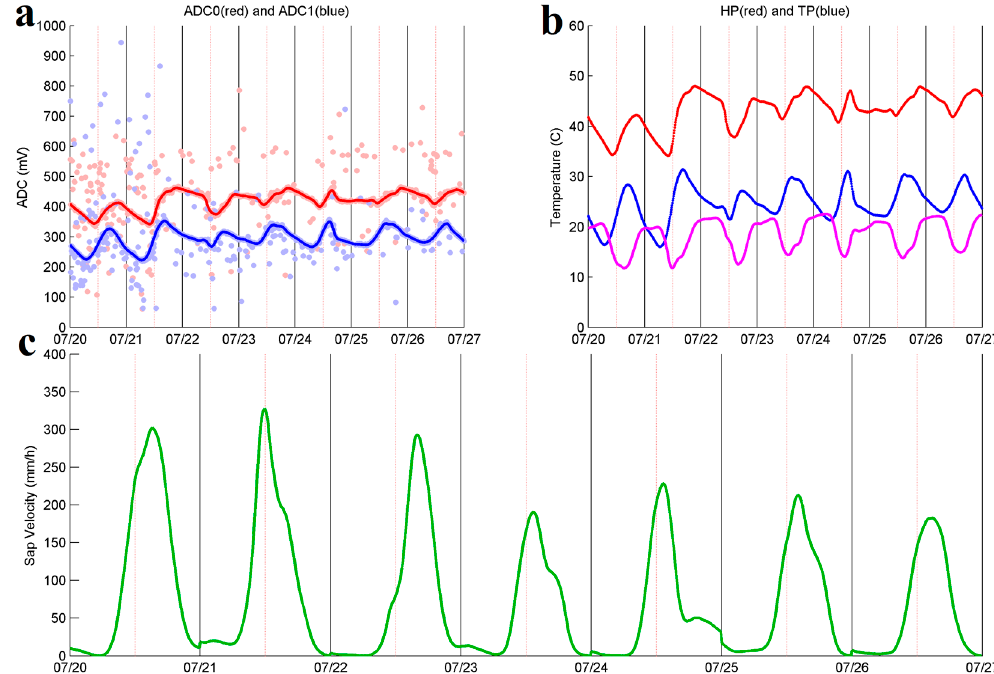
Figure 9. Sap flow results for node 2084 between 20 and 27 July 2016. ( a ) Raw voltages (i.e., ADC in mV) from the HP (red scatter plot) and TP (blue scatter plot) between 0 and 1000, and smoothed plot for the HP and TP in red and blue, respectively; ( b ) Filtered and smoothed temperatures for the HP (red) and TP (blue) from the raw voltages ADC0 and ADC1 respectively, difference in temperature (HP-TP) in Celsius degrees (magenta); ( c ) Sap flow time series (mm/h).